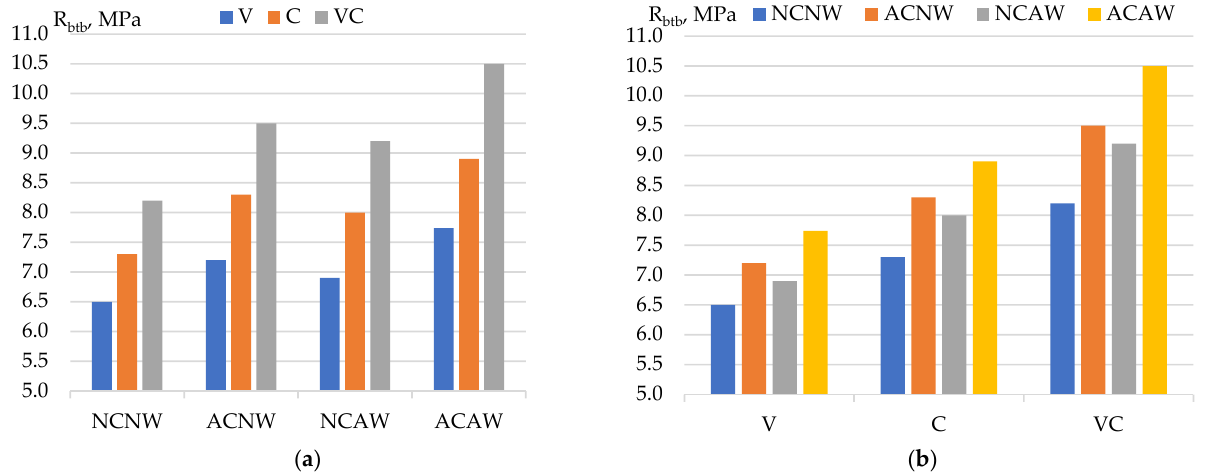
Figure 7. Dependence of the tensile strength in bending of concrete: ( a ) on the type of activation, ( b ) on the type of technology for its manufacture.